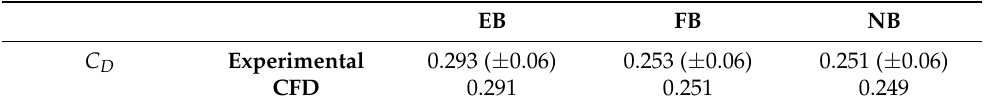
Table 2. Comparison between CFD and experimental drag coefficient results of the three baseline configurations in